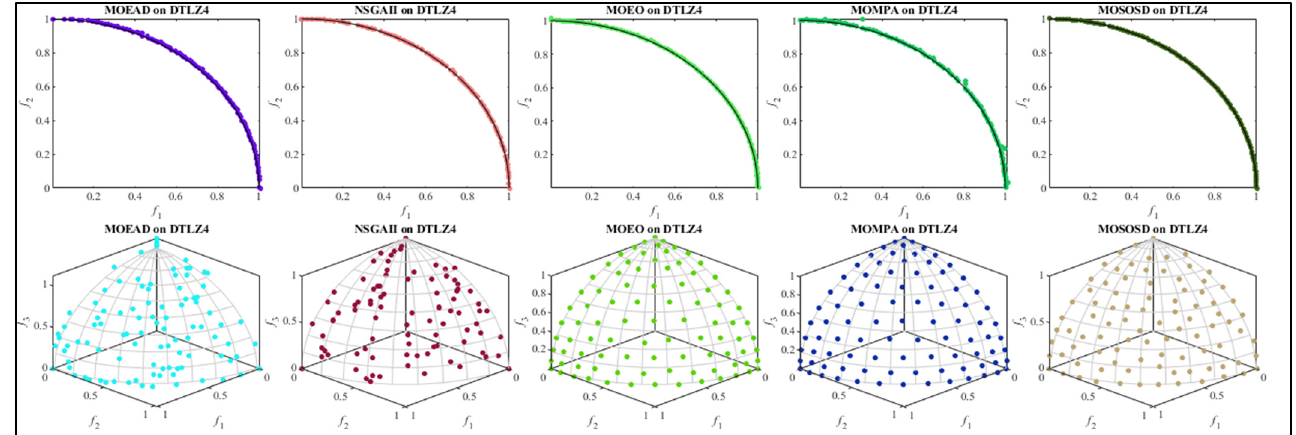
Figure 5. The Pareto front for DTLZ4 using various algorithms at 𝑀 = 2, 3 .